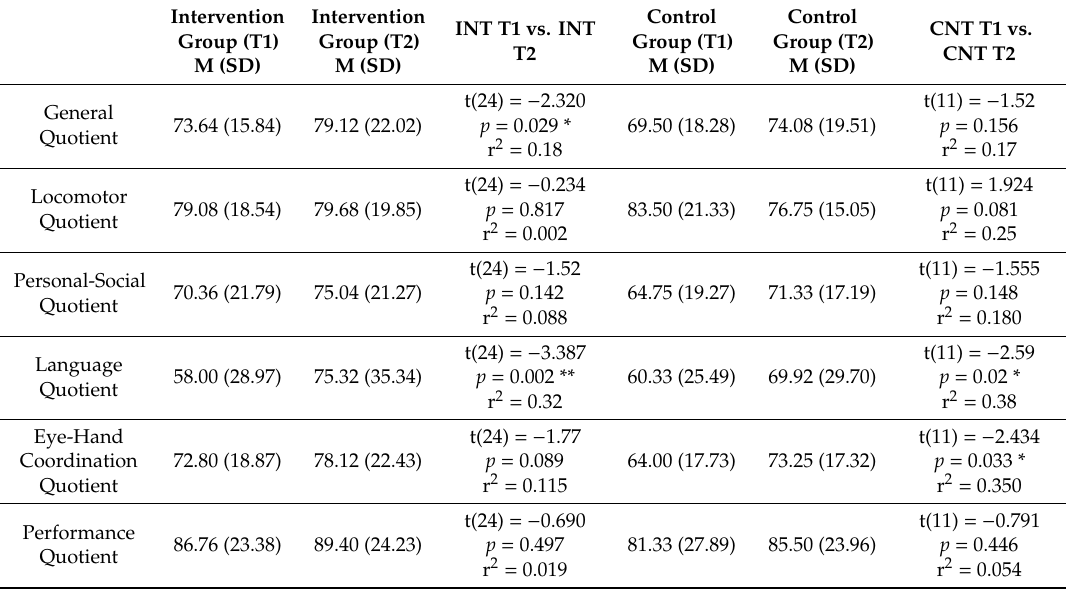
Table 2. Developmental quotients in the two groups at T1 and T2.